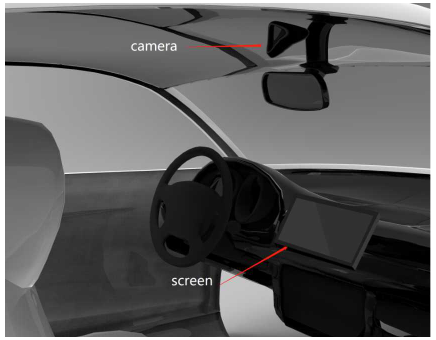
Figure 6. Commissioning